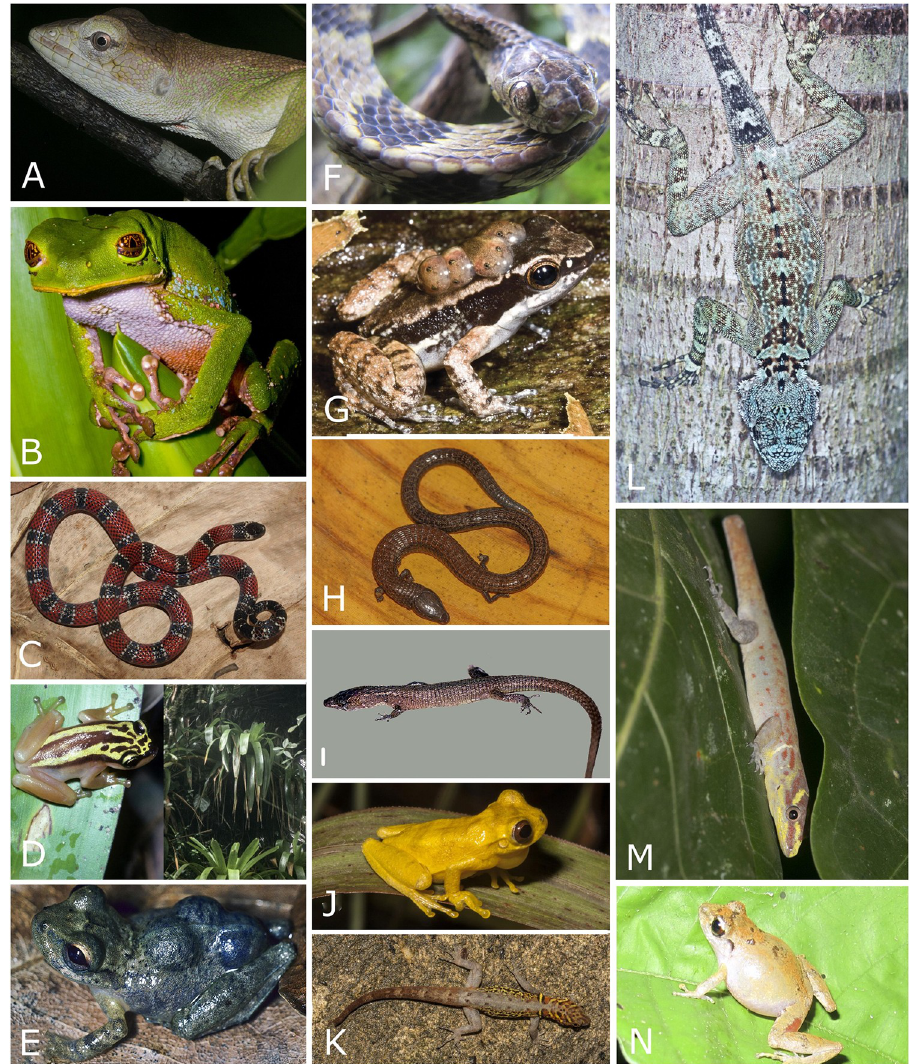
Fig 10. Some Trinidad amphibians and reptiles. A. The Venezuelan Bush Anole, Polychrus auduboni . B. Trinidad Leaf-nesting Frog, Phyllomedusa trinitatis . C. Trinidad Coral Snake, Micrurus circinalis . D. Golden Treefrog, Phytotriades auratus . E. Stimson’s Parrot Snake, Leptophis stimsoni . F. Trinidad Snail-eating Snake, Dipsas trinitatus (Trinidad endemic). G. Trinidad Stream Frog, Mannophryne trinitatis (a male transporting tadpoles endemic). H. Hex-scaled Bachia, Bachia trinitatus . I. Luminous Lizard, Oreosaurus shrevei . J. Minute Yellow Treefrog, Dendropsophuscf minutus , K. Variegated Gecko, Gonatodes ceciliae . L. Caribbean Tree Runner, Plica caribeana . M. The Trinidad Spot-nosed Gecko, Gonatodes ferrugineus . N. Urich’s Rain Frog, Pristimantis urichi . Photo credits John C Murphy (A-N).